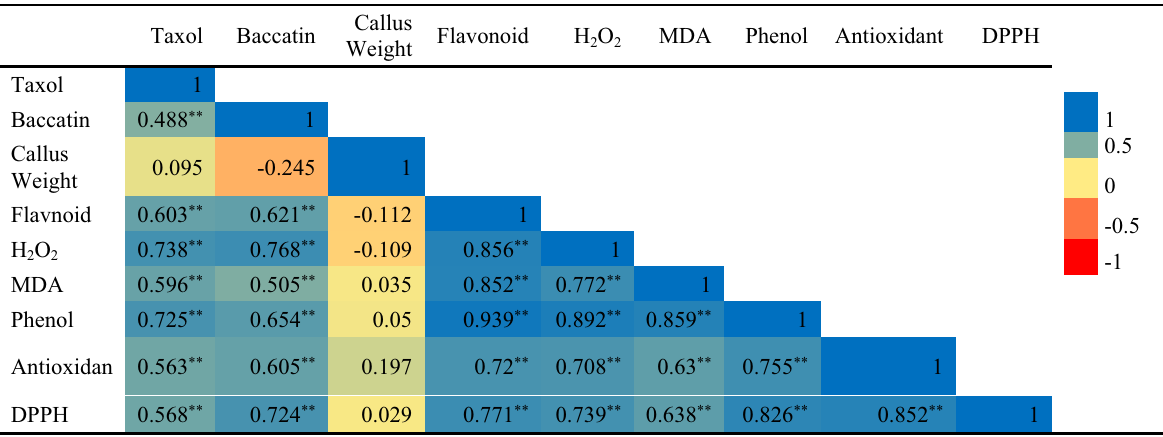
Table 3 Correlation analysis between callus growth, secondary metabolites, and biochemical properties in the Corylus avellana callus